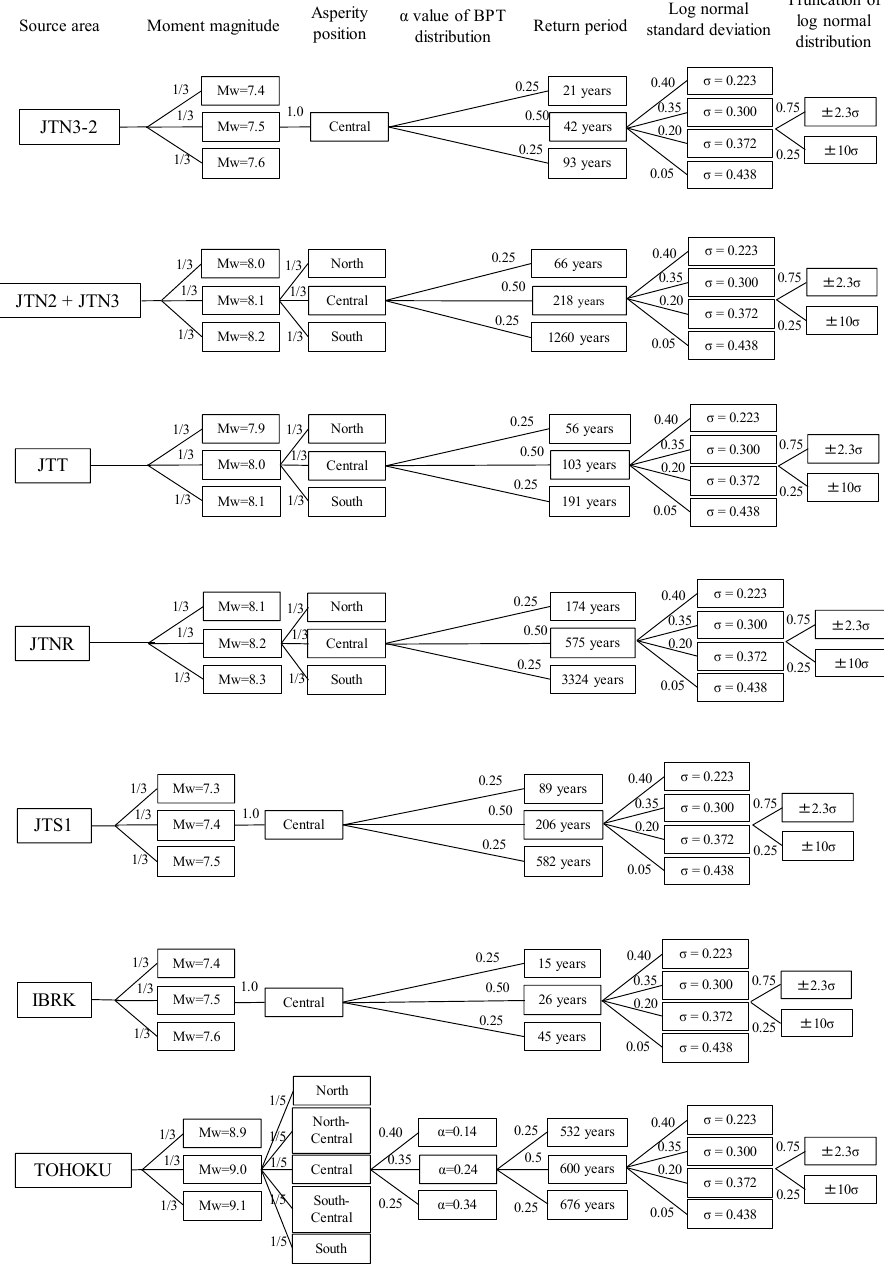
Figure 5. Logic trees constructed for the eleven fault regions. The numbers appended onto the branches of the logic trees are the weights of the branches.